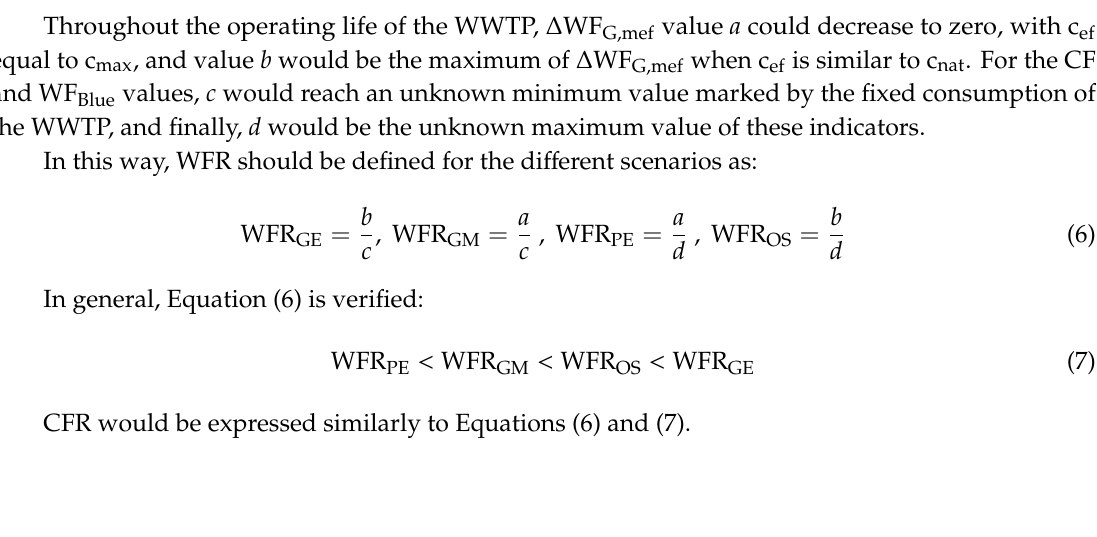
Figure 3. Variation of indicators ∆ WF G,mef , WF Blue and CF in operating range of a WWTP during a specific time interval (t) with a, b are the minimum and maximum values of ∆ WF G,mef in this period, respectively, and c and d the maximum and minimum values of WF Blue or CF in the same period. Where c ef is the concentration of effluent of a determined pollutant, c max is the concentration allowed by the standard and cnat is the concentration of respective pollutant measured in receiving body of water. Possible operational limits of WWTP in time t and for its life period, where GE, good environmental performance limit; GM, good manager performance limit; OS, operational scenario to reduce consumption; PE, poor environmental performance limit.